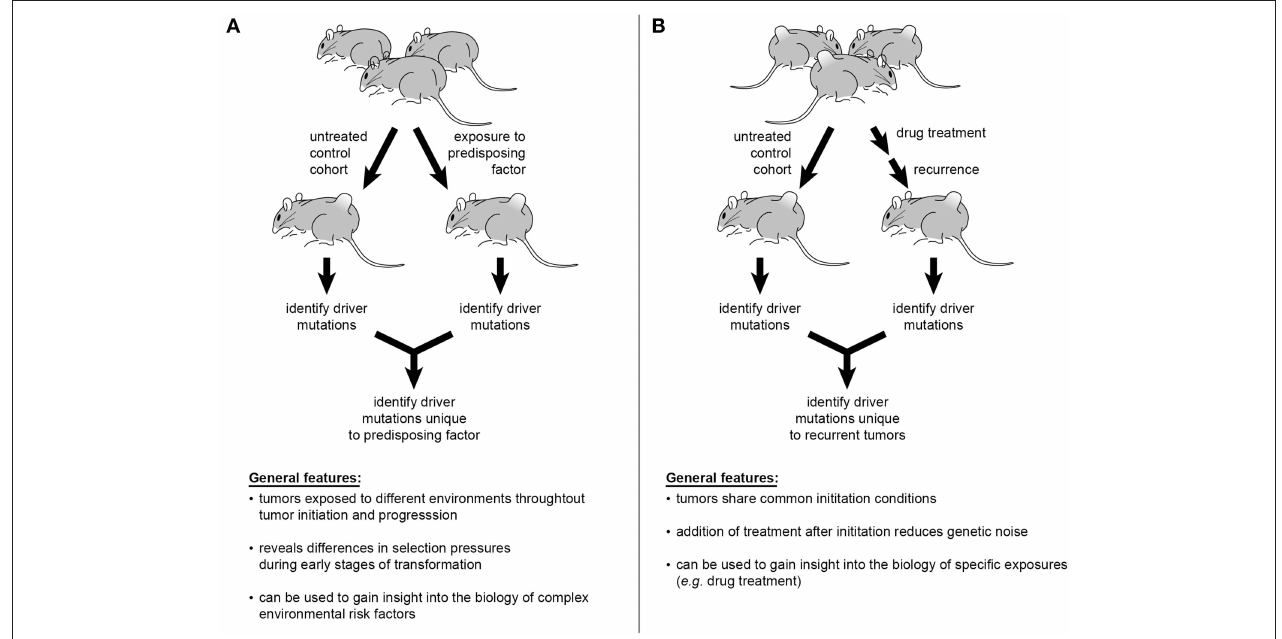
FIGURE 3 | Sleeping Beauty mouse models can be used to interrogate a variety of influences on cancer genetics. Incorporation of epidemiologically described risk factors into study design offers the ability to identify the genetic alterations mediating tumorigenesis in at-risk populations (A) . The multiplexing of various pharmacological therapies used in the treatment of cancer patients would permit tracking of genetic changes leading to disease recurrence and progression (B)